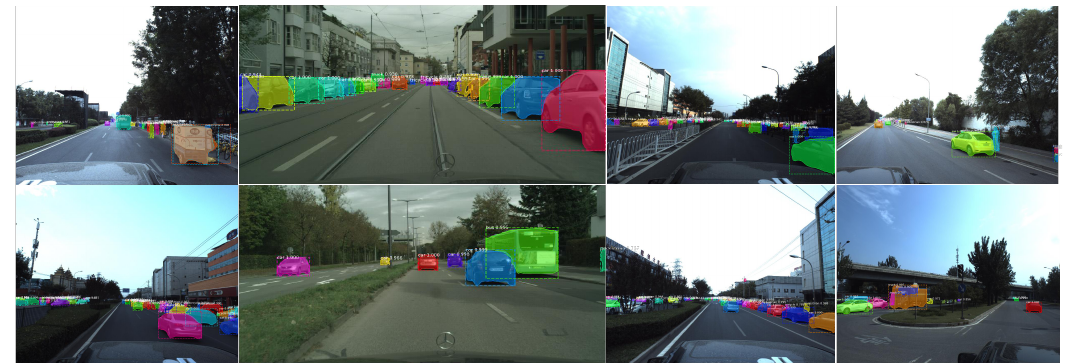
Figure 7. Images in each row are the object detection and instance segmentation results. Table 5. Object detection results using Mask R-CNN [18] evaluated on the 2018 WAD test-dev set: ( a ) object detection results on separate class of 2018 WAD test-dev ; and ( b ) object detection results of 2018 WAD test-dev